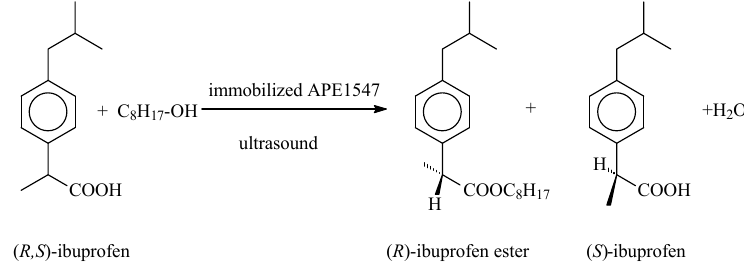
Scheme 1. Schematic diagram of the resolution of ibuprofen.